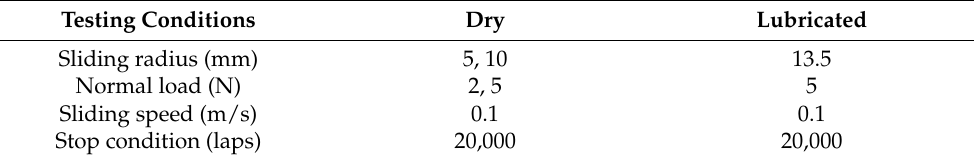
Table 4. Experimental conditions employed in the ball-on-disk tribological tests.